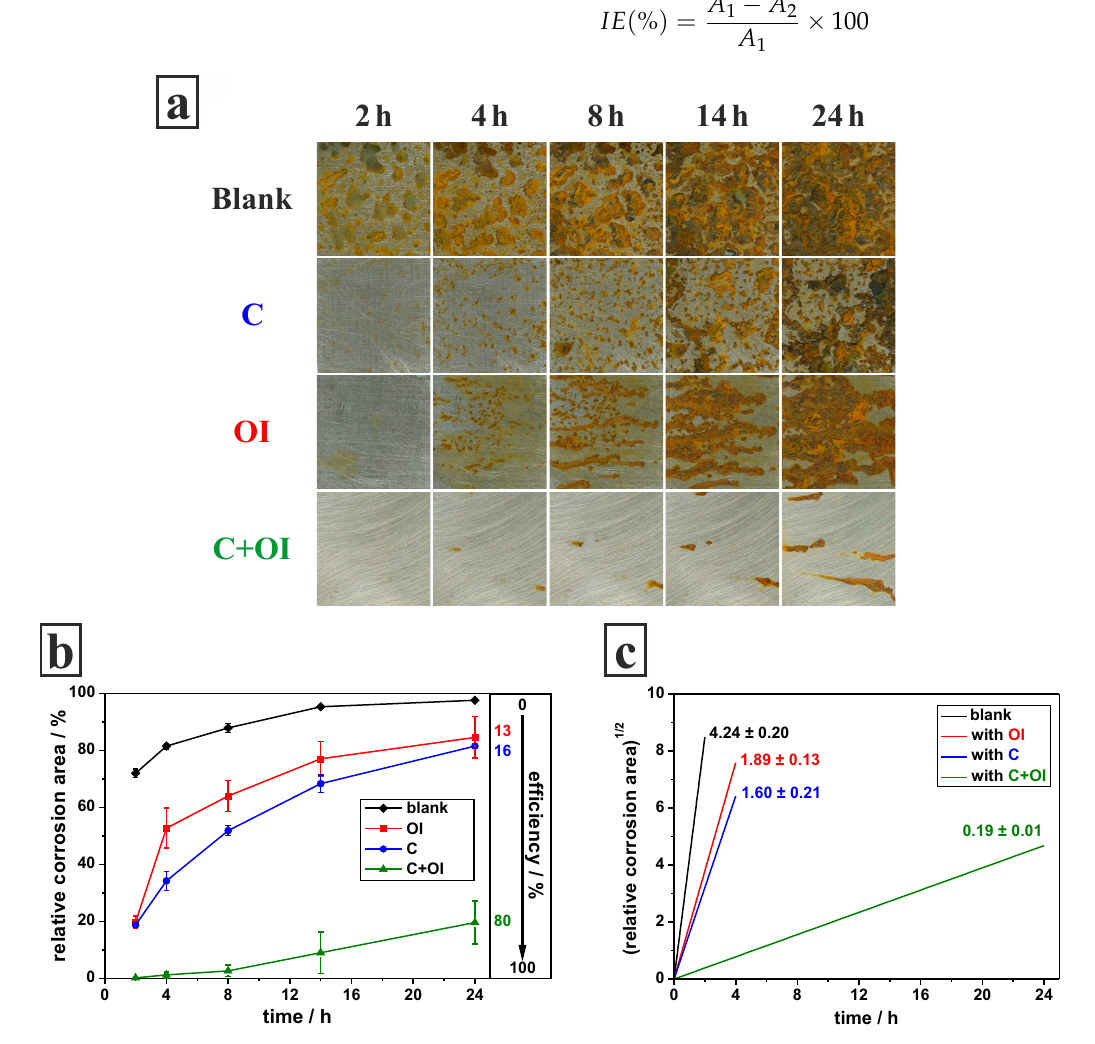
Figure 7. ( a ) Visible corrosion propagation for blank steel (black) and in the presence of 50 mmol/L C (blue), OI (red), and C + OI (green) each at the indicated times. In all cases, only one exemplary run of ten independent specimens with characteristic corrosion patterns is shown. ( b ) Presentation of the averaged relative corrosion areas during the test period for untreated and treated series with an indication of the IE in % at 24 h. ( c ) Linear approximation displaying the root of the relative corrosion area to the exposure time. The course of the linear performance and the calculated slope is given according to the color code. (Data points are marked with lines for better